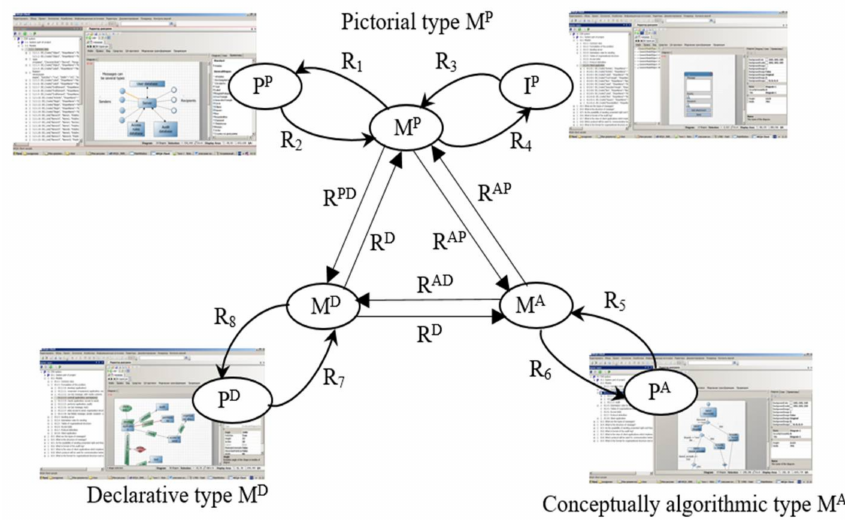
Figure 18. Normative types of visual